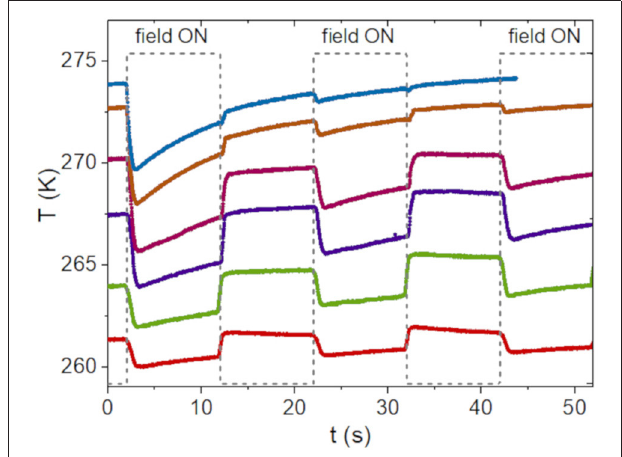
FIGURE 6 | Temperature variation of the B250 sample induced by subsequent application and removal of a 1.8-T magnetic field.